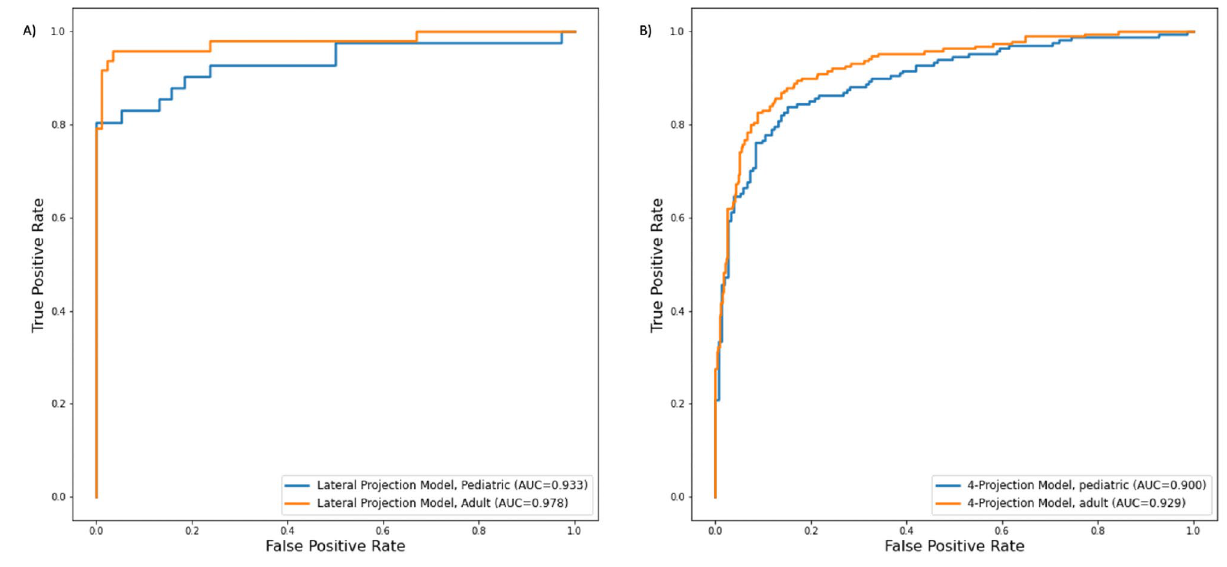
Figure 6. AUC curves obtained from best training iterations for Model A with lateral projection data ( A ) and Model B with 4-projections data ( B ) in pediatric and adult patients. AUC = Area Under the Curve.